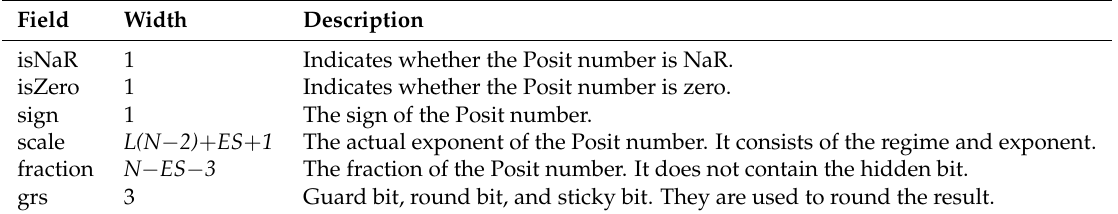
Table 2. The six fields of the united intermediate data structure. NaR, not a real